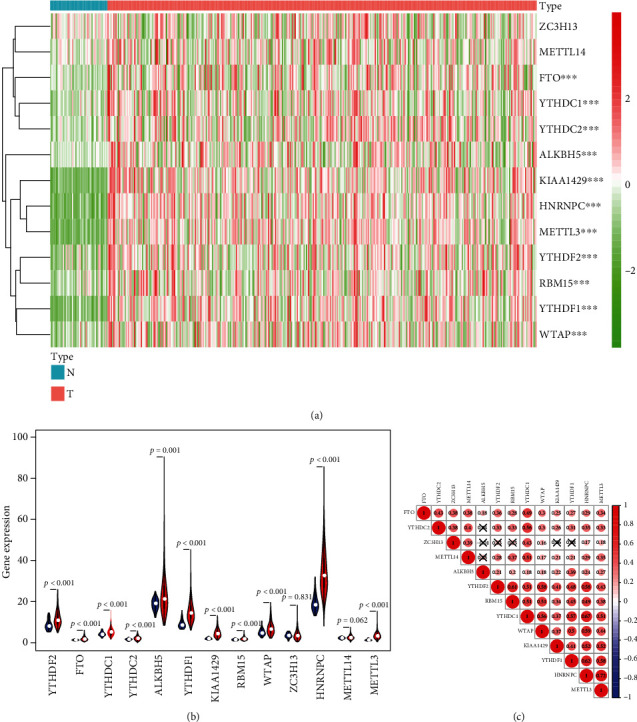
The profiling of m6A RNA methylation regulators in hepatocellular carcinoma. (a) The heatmaps of 13 m6A RNA methylation regulators in tumor tissues and normal tissues (red is upregulated and green is downregulated; ∗p < 0.05, ∗∗p < 0.01, and ∗∗∗p < 0.001). (b) Vioplot visualizing the differentially m6A RNA methylation regulators in hepatocellular carcinoma (red is gastric cancer and blue is normal). (c) Spearman's correlation analysis of the 13 m6A modification regulators in hepatocellular carcinoma.